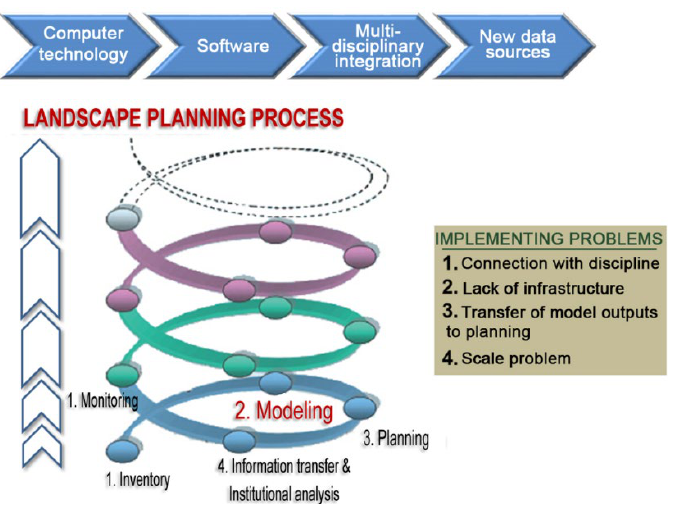
Figure 2 Spatial Modelling Development